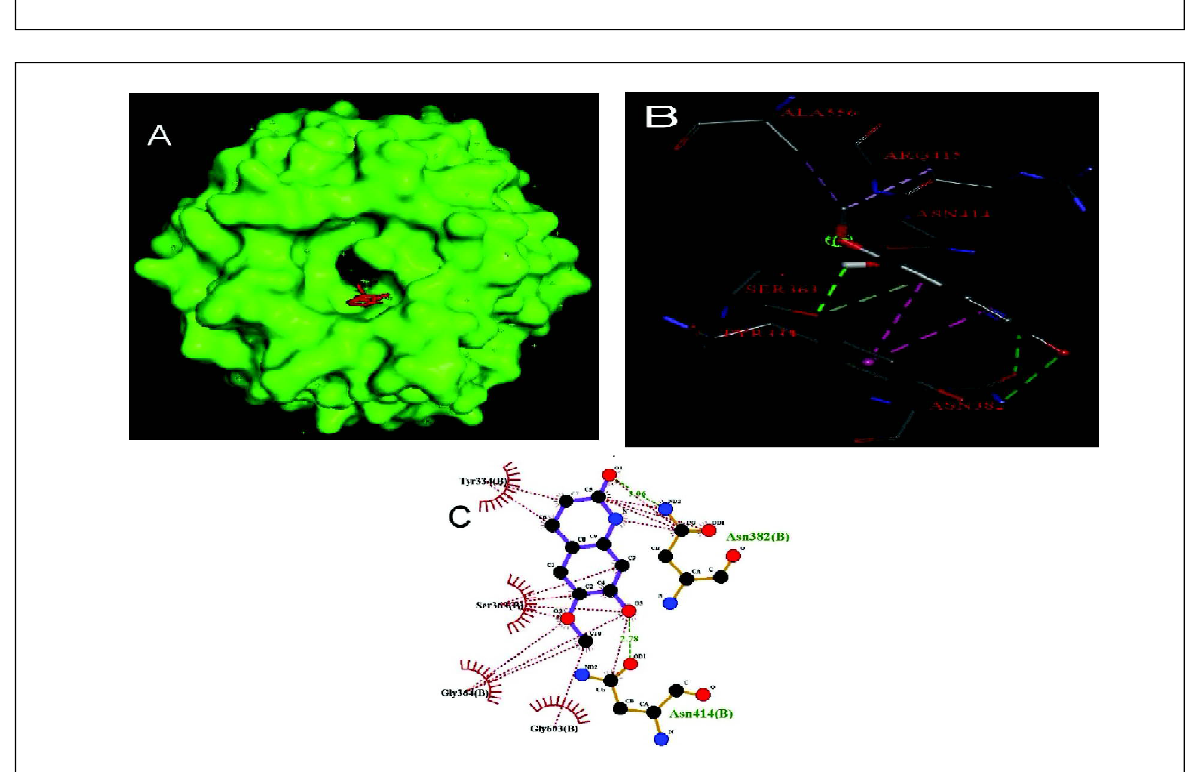
Figure 11: The pictorial illustrations for the Scopoletin-1 derivative in the Kelch domain (PDB: 4L7B), including the surface view of the top-ranked docked pose (A), interaction analysis from Accelrys discovery studio (B) and the same from LigPlot